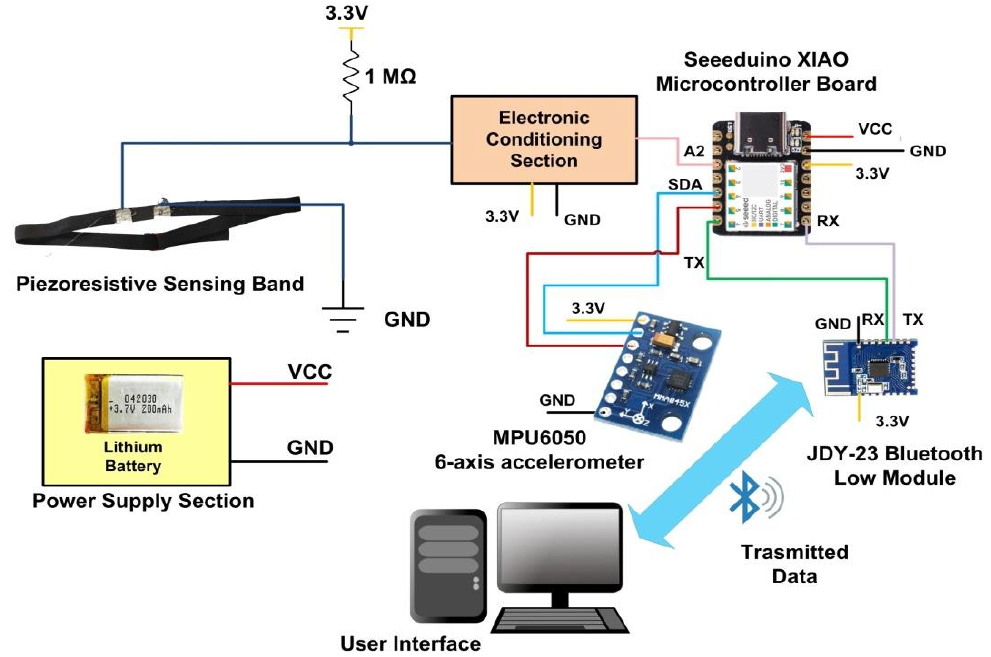
Figure 3. Architecture of developed piezoresistive chest band.